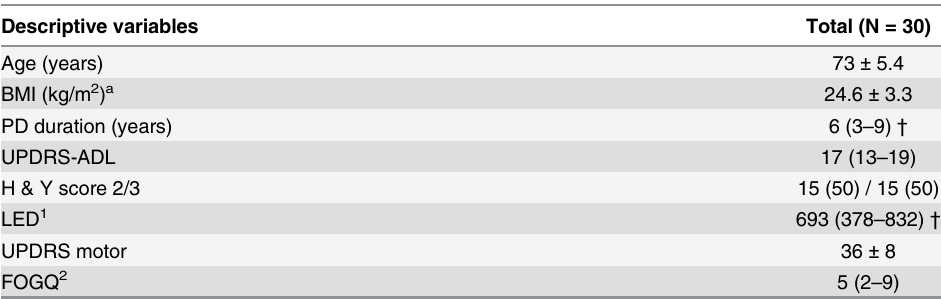
Table 1. Participant characteristics.